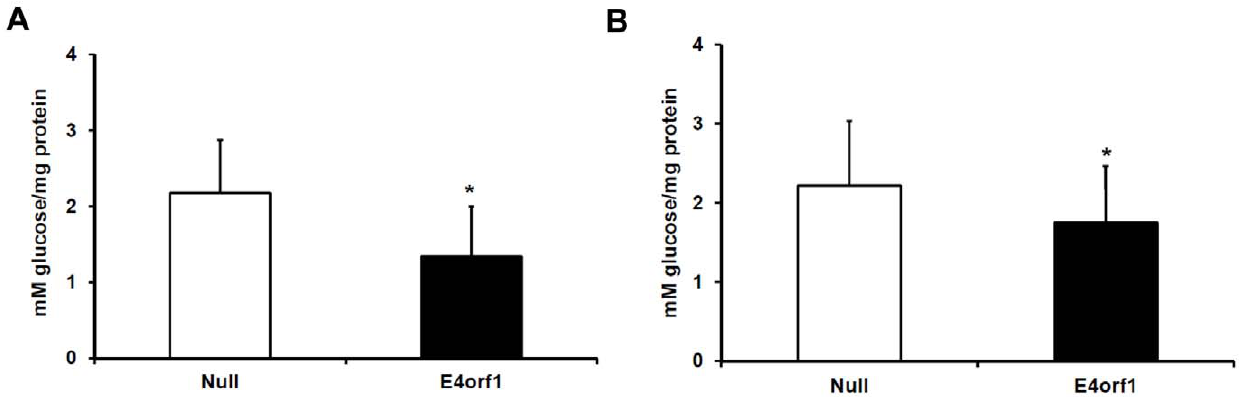
Figure 2. Glucose Output from Primary Hepatocytes Transfected with E4orf1. Glucose output in mouse primary hepatocytes after transfection with E4orf1 or null vector. A) Glucose output by primary hepatocytes after serum and glucose starvation for 1.5 hours, expressed as mean mM glucose per mg protein 6 SD. E4orf1suppressed glucose output compared to Null vector (p=0.0001). B) Glucose output in primary hepatocytes treated with 100 nM glucagon in serum-free, and glucose-free media for 1.5 hr. E4orf1 suppressed glucose output in this condition (p=0.029). Expressed as mean mM glucose per mg protein, 6 SD.